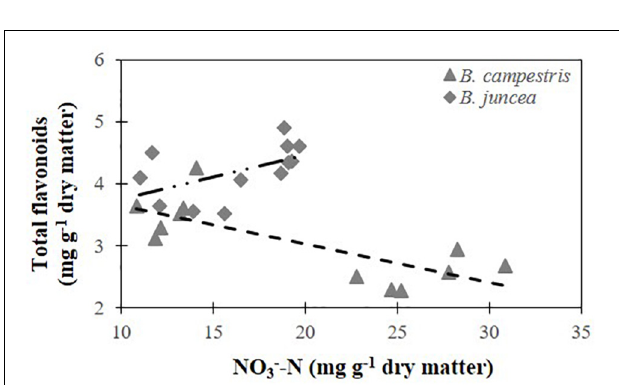
FIGURE 6 | Relationship between total flavonoid concentration and nitrate concentration in two Brassica species. Total flavonoids in B. juncea cv. Red Giant = 3.040+ 0.071 · (NO 3 − -N) ( R 2 = 0.279). Total flavonoids in B. campestris cv. Mibuna Early = 4.269 – 0.062 · (NO 3 − -N) ( R 2 = 0.576 ∗